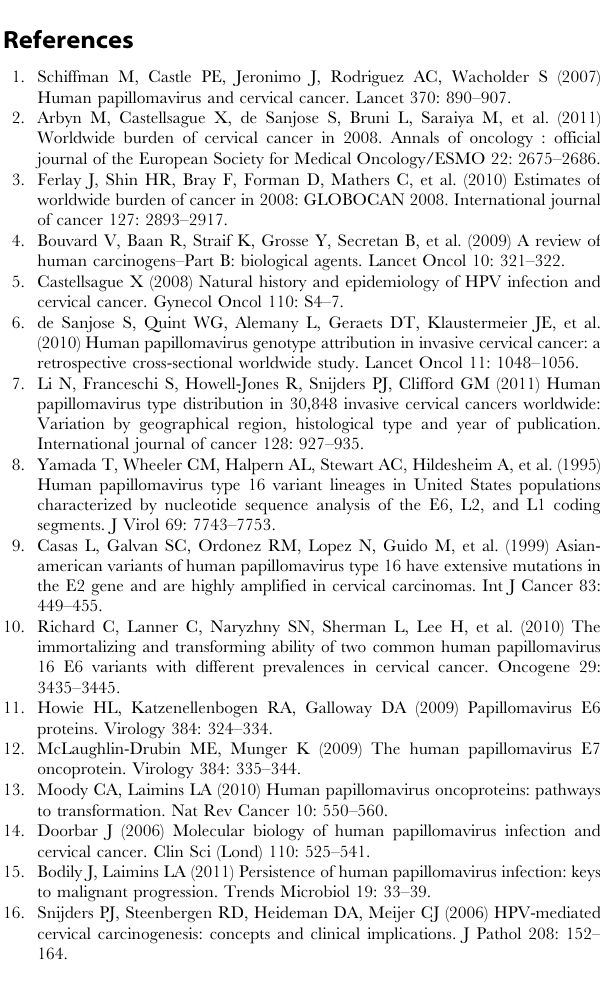
Table S5 Cellular genes directly targeted by HPV16 DNA integration. Table S6 First cellular genes within 500 kb downstream of integrated HPV16. Table S7 Primer combinations for